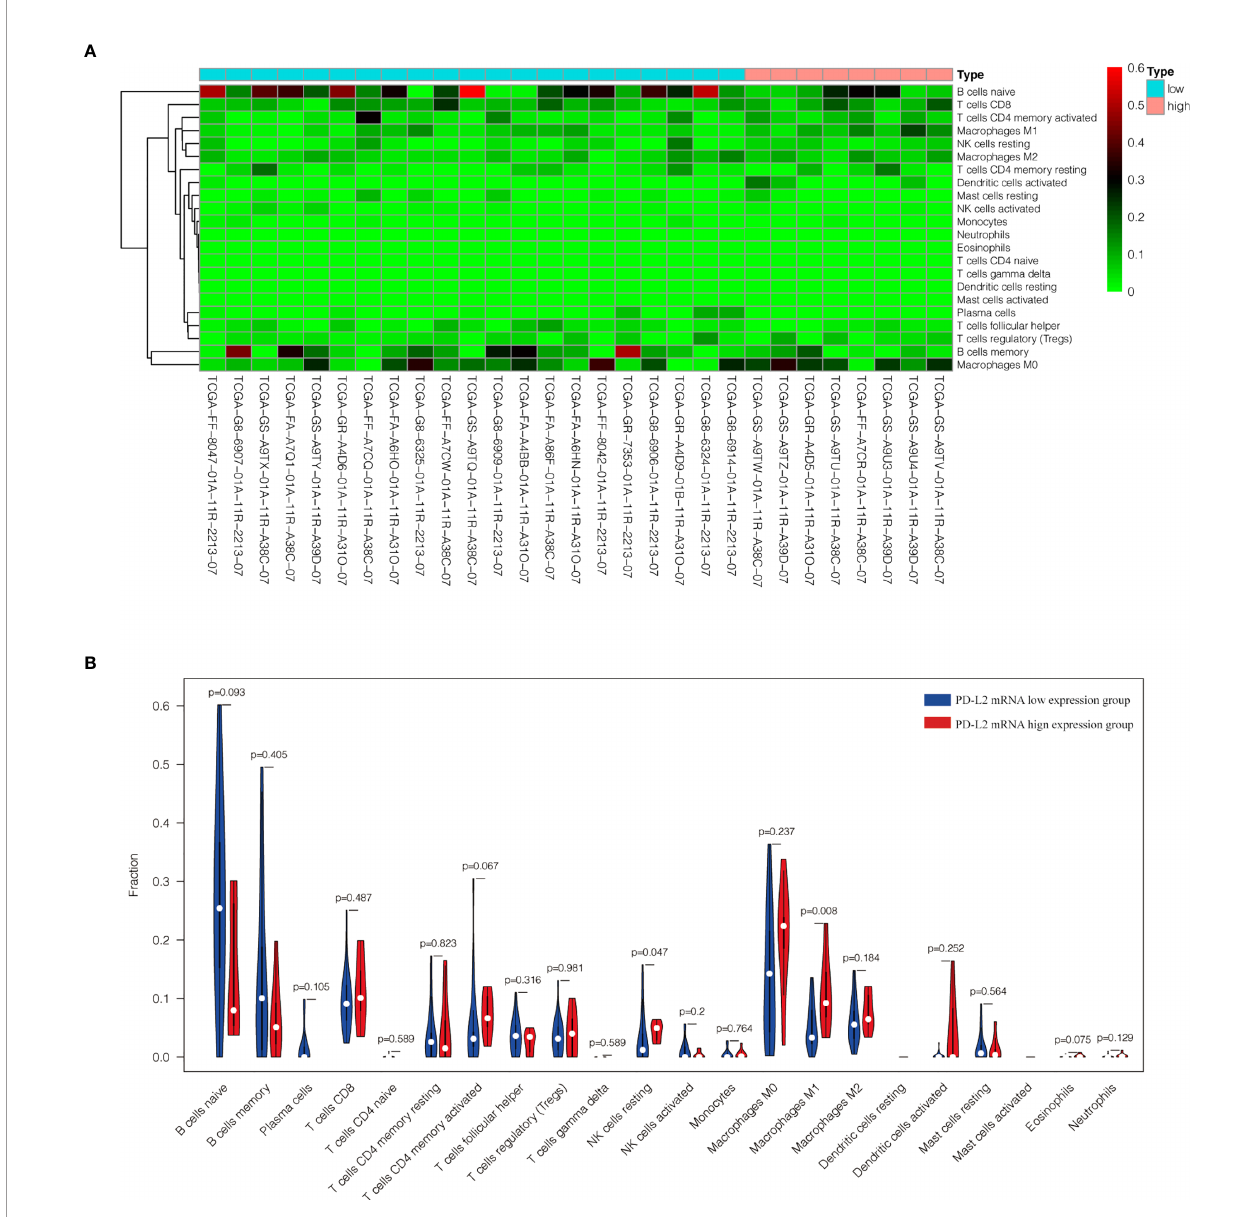
FIGURE 4 | Content of 22 immune cells in 29 DLBCL samples from TCGA database (A) . Analysis of the difference of 22 immune cells between high and low expression groups of PD-L2 mRNA (B)